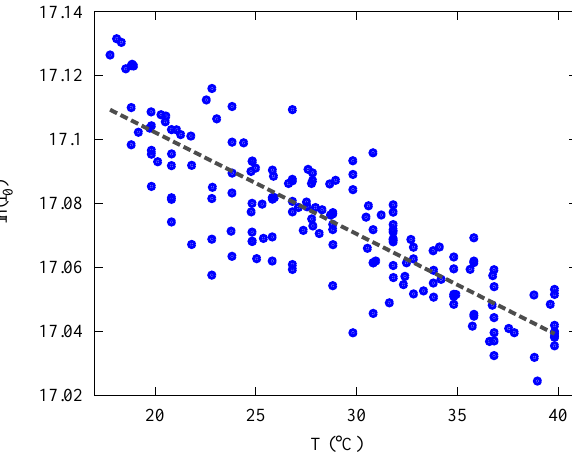
Figure 2. Relation between the transferred ETCs and the Brewer internal temperature. The dashed line represents a linear regres- sion and indicates a decrease of the Brewer sensitivity of about 0.3%K − 1 .